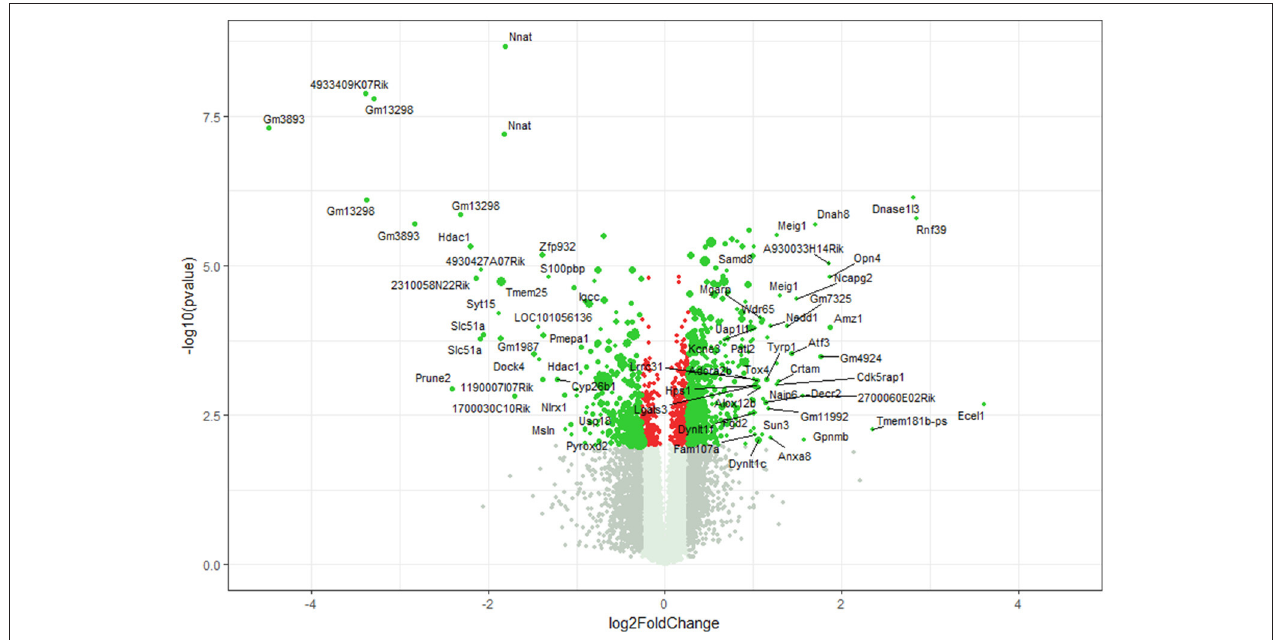
FIGURE 1 | Volcano plot microarray data. Color green, p ≤ 0.01, fold change ≥ 1.2; labels, p ≤ 0.01, fold change ≥ 2.0; dot size represents relative expression values of wildtype